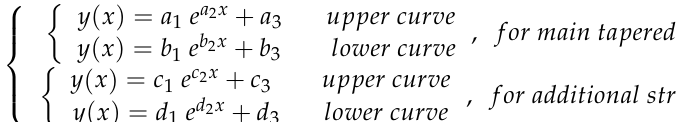
Figure 1. Antipodal Vivaldi antenna configuration with ( a ) different widths of tapered strips, and ( b ) their reflection co- efficient and gain.